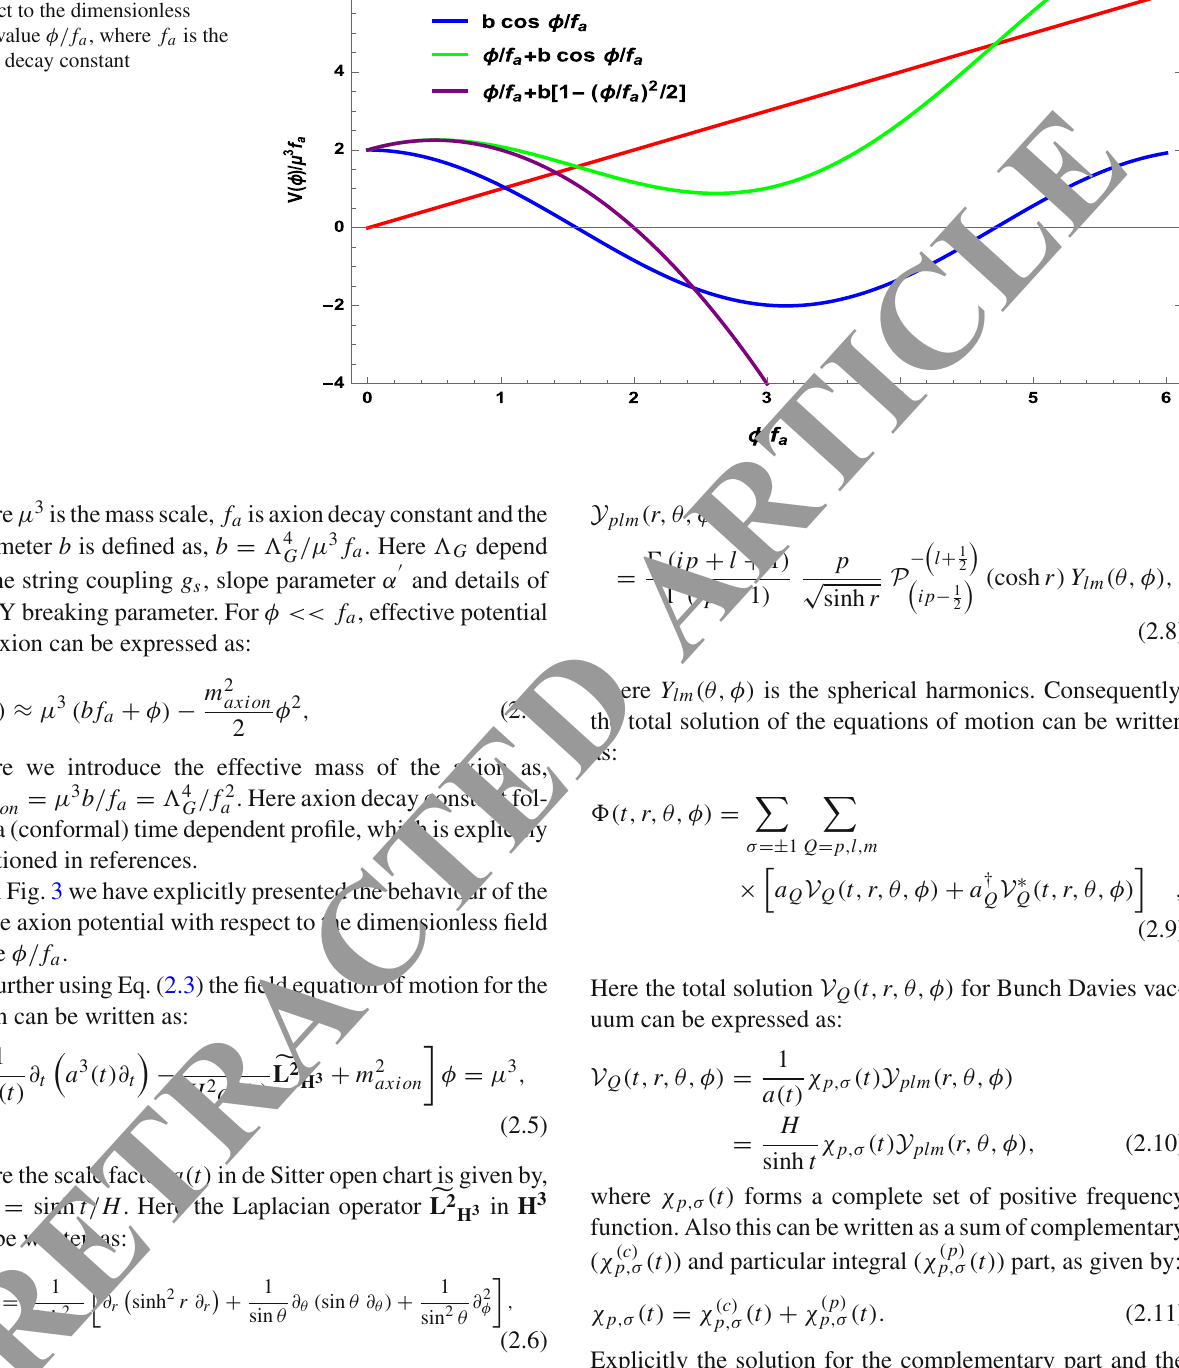
Fig. 3 Behaviour of the axion effective potential obtained from Type IIB String Theory with respect to the dimensionless field value φ/ f a , where f a is the axion decay